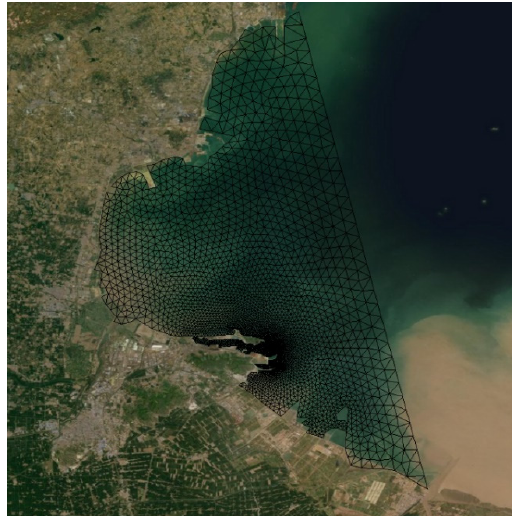
Figure 2. Study area and mesh.